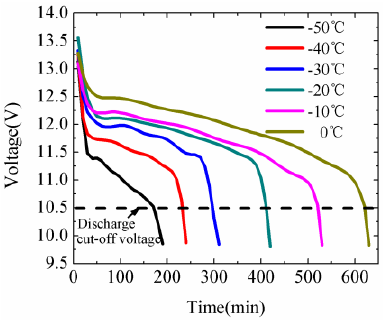
Figure 7. Discharge curves of the lead – acid battery at low temperatures.